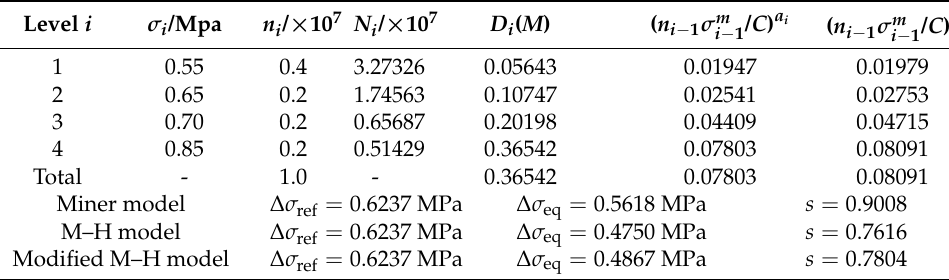
Table 5. Four-level loads designed in the low-and-then-high loading